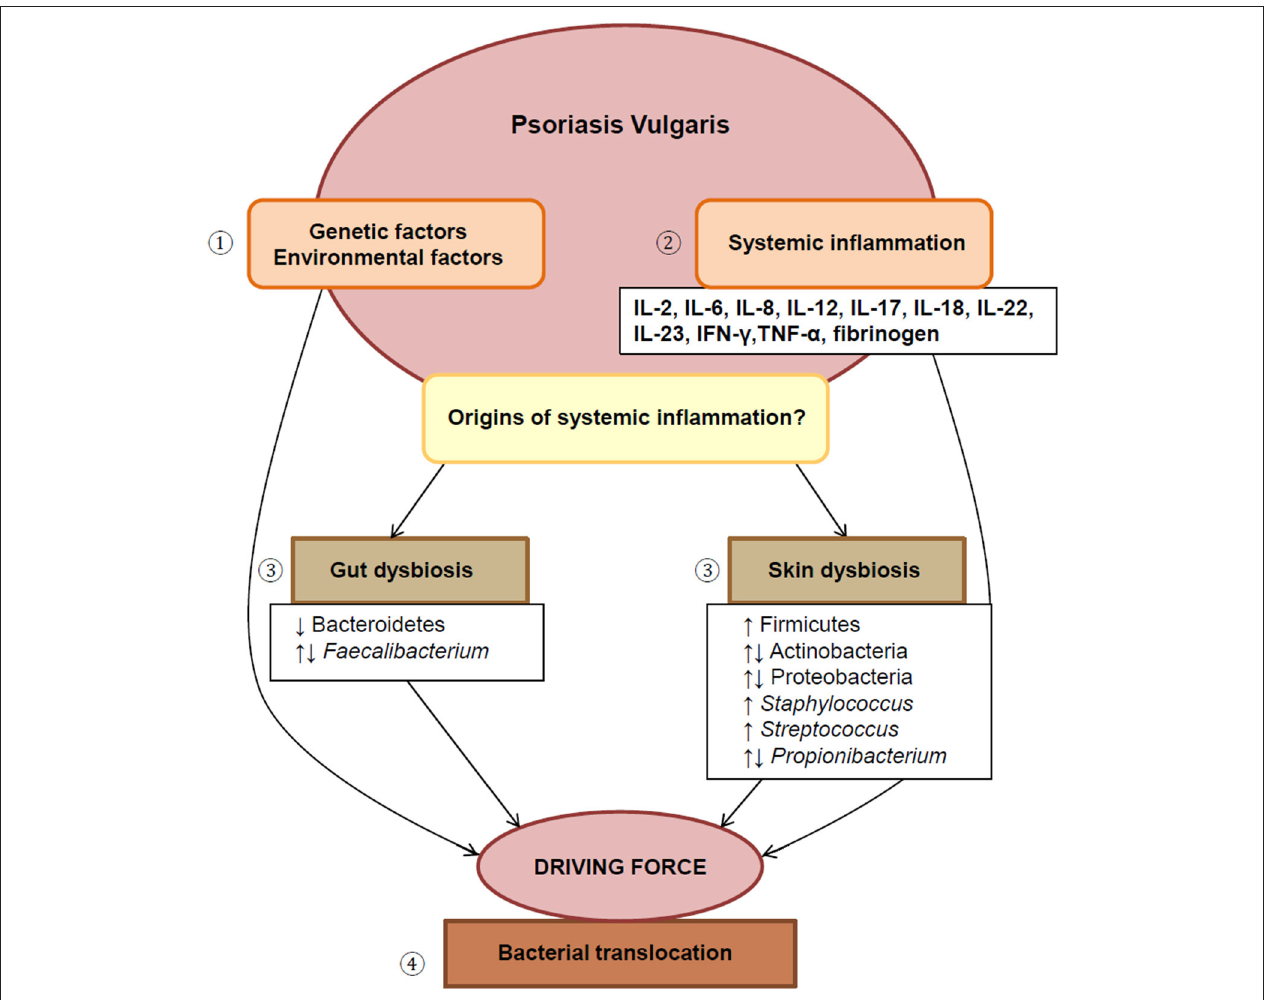
FIGURE 1 | An overview of this paper. (1) The etiology of PV involves complex interplay between genetic and environmental factors. (2) This disease displays localized as well as systemic inflammation, reflected by the presence of various dysregulated inflammatory markers. (3) Dysbiosis of both the gut and skin microbiome are suggested as possible drivers of chronic systemic inflammation, (4) by facilitating the translocation of bacteria from these sites into systemic circulation. IL, interleukin; IFN- γ , interferon-gamma; TNF- α , tumor necrosis